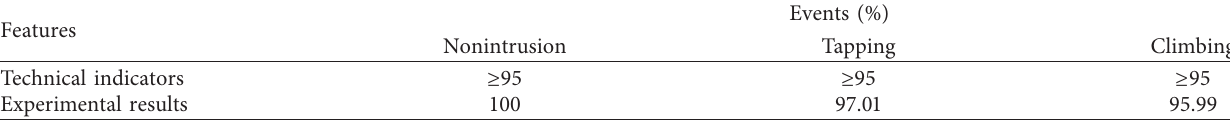
Table 3: Comparison of the intrusion recognition accuracy rate of experimental results with technical